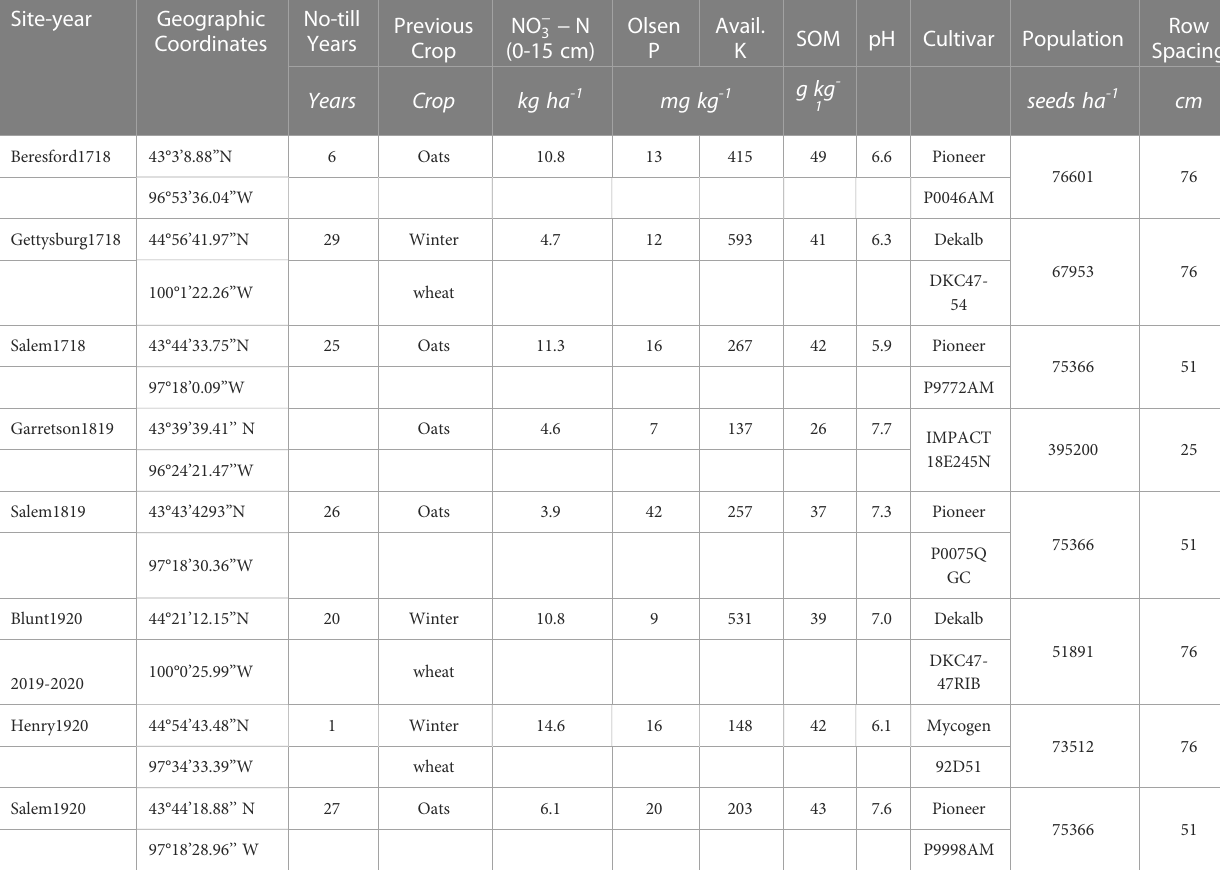
TABLE 1 Preplant soil and agronomic management characteristics of all site-years under the